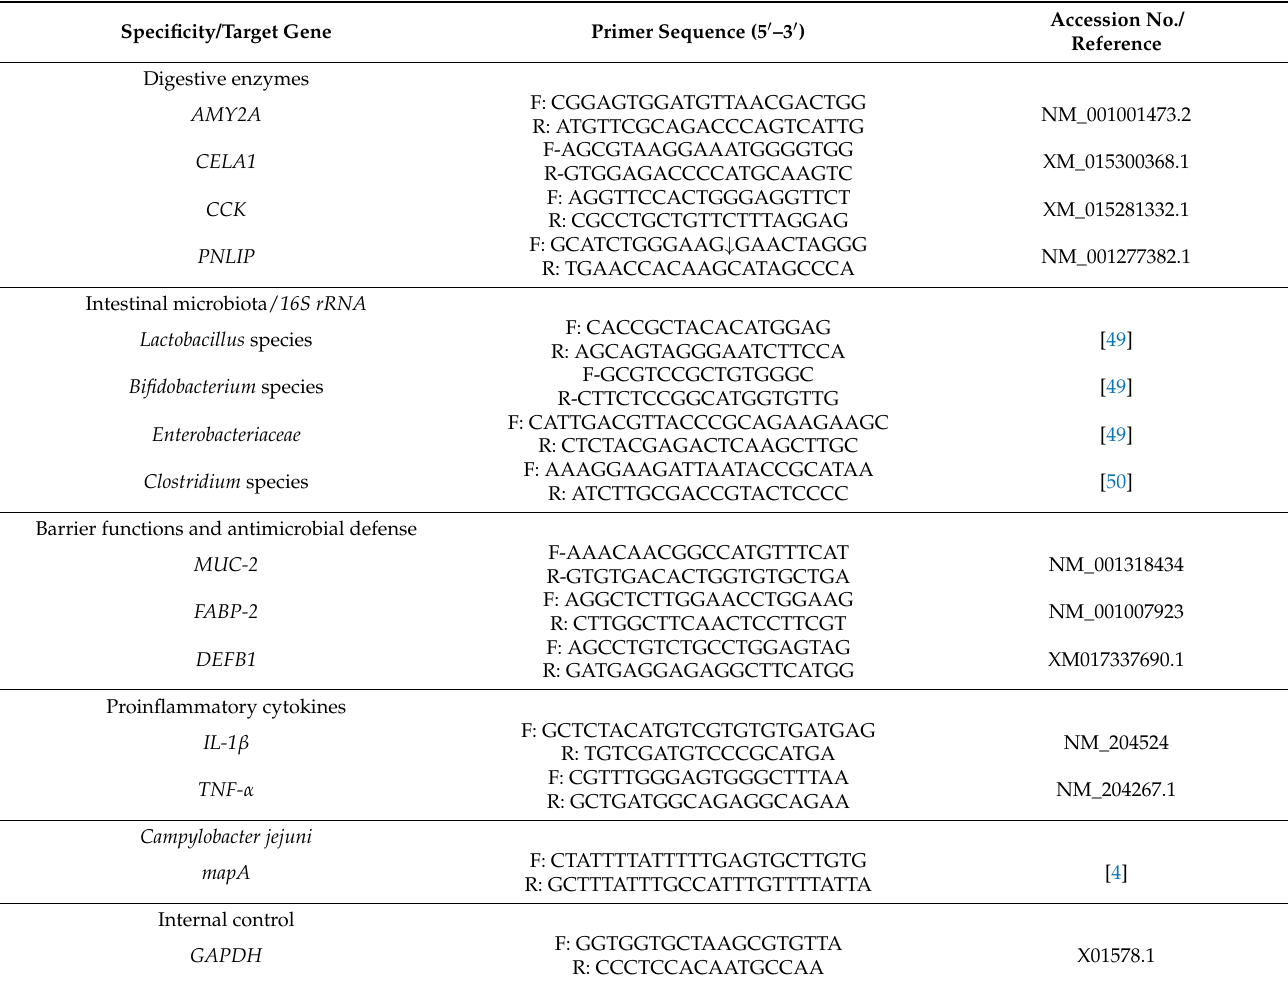
Table 2. Target genes and primers used for qPCR